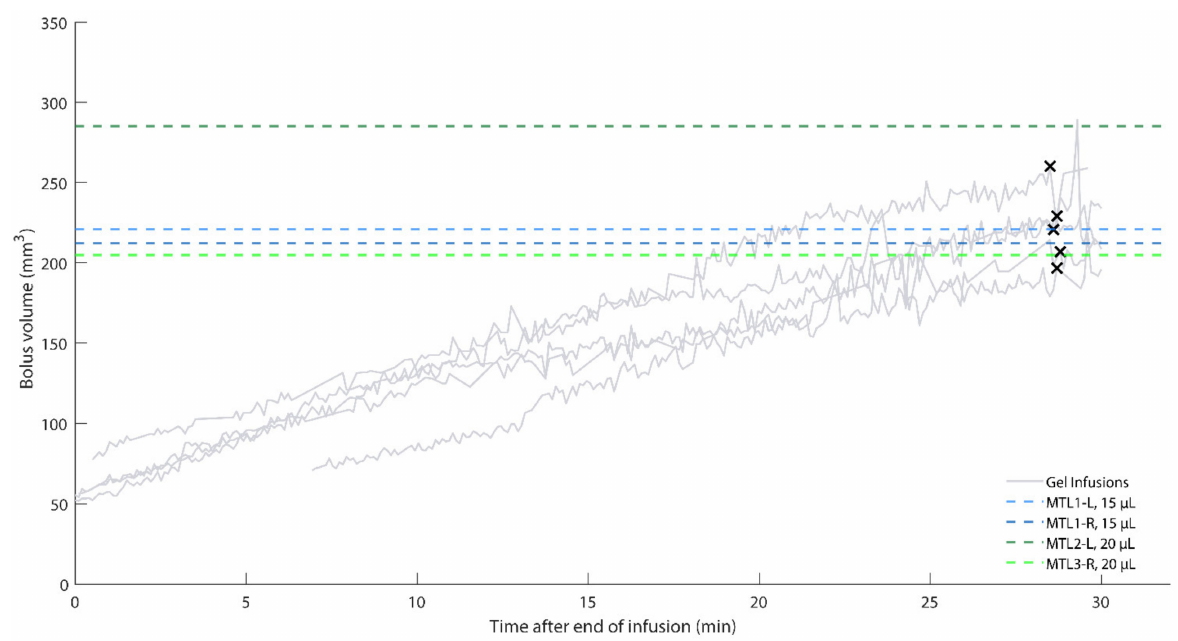
Figure 7. MTL MRI data compared with MTL agar data after CED completion. Some trials lack data early in the diffusion process due to the bolus being difficult to identify. Black Xs indicate the final point used for statistical analysis from each agar trial. The final chosen points may be shifted slightly to avoid noise spikes. All agar infusions were 15 µ